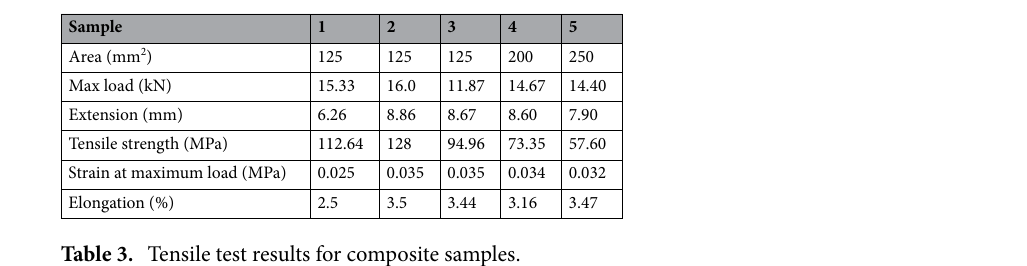
Table 3. Tensile test results for composite